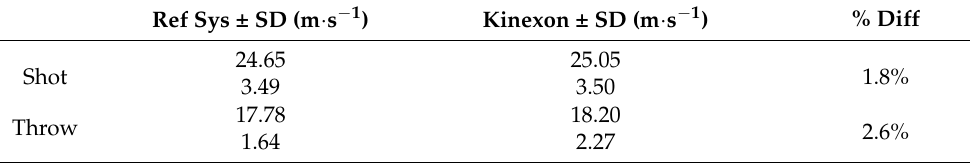
Table 5. 2D peak speed of shots and throws.